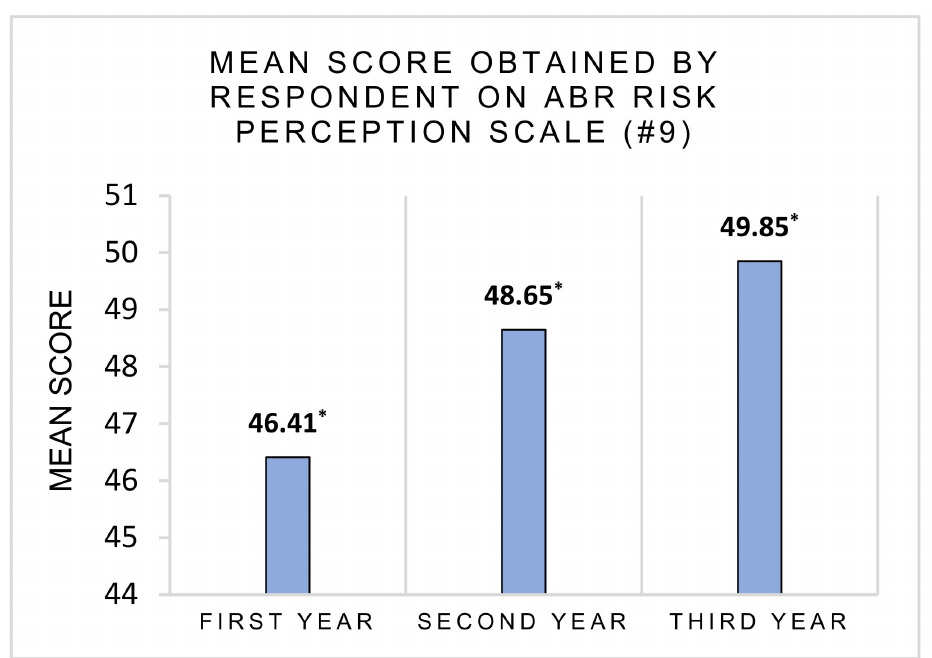
Figure 6. Perception of ABR risk depending on the year of study. The higher the score is, the higher the risk perception is. * Score is the sum of the answers to the items of question